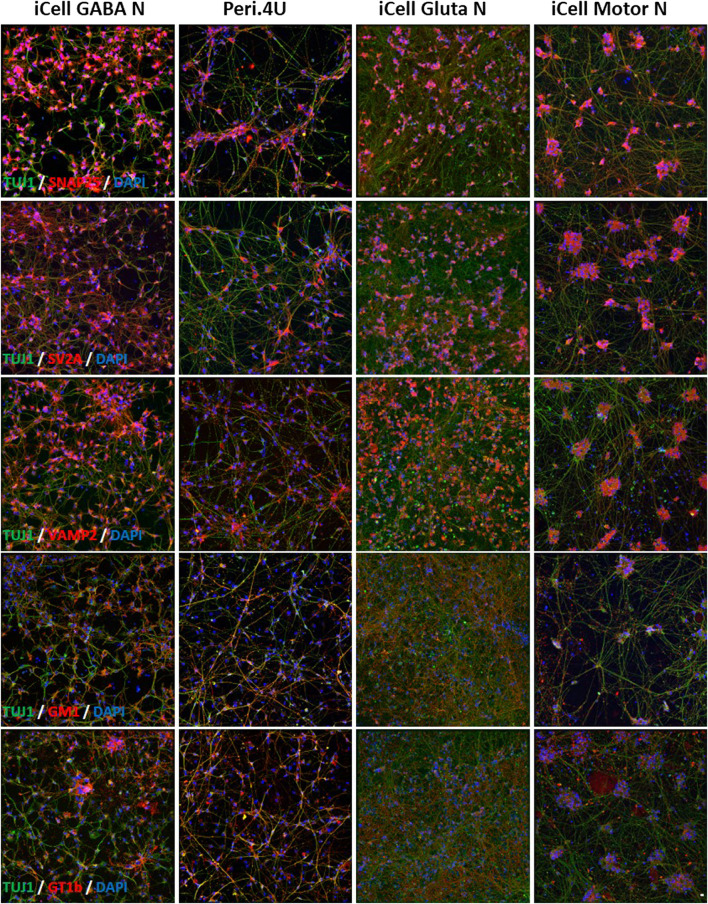
 Immunolabelings of hiPSC-derived Neurons at day 15 after thawing: (A–E) TUJ1 (green) and (A) SNAP25 (red); (B) SV2A (red); (C) VAMP2 (red); (D) GM1 (red) and (E) GT1b (red). Nuclei are stained in blue (DAPI). Scale bar: 25 μm.